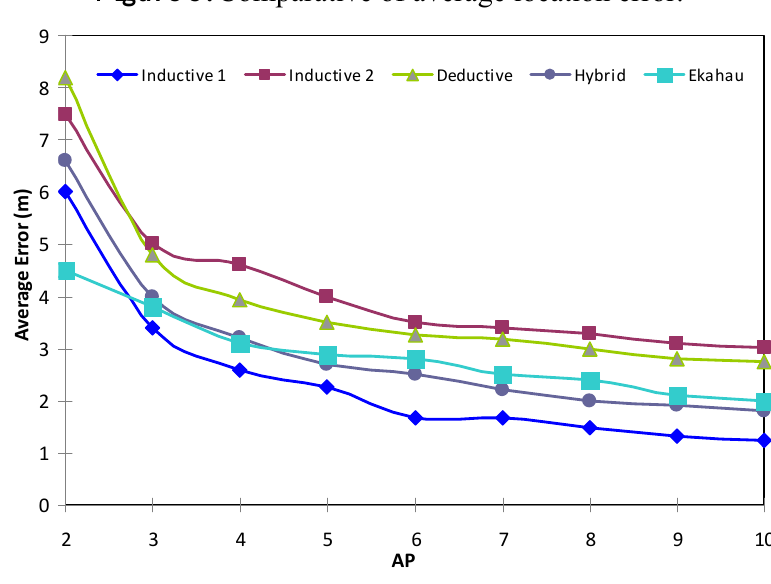
Figure 5. Comparative of average location error.